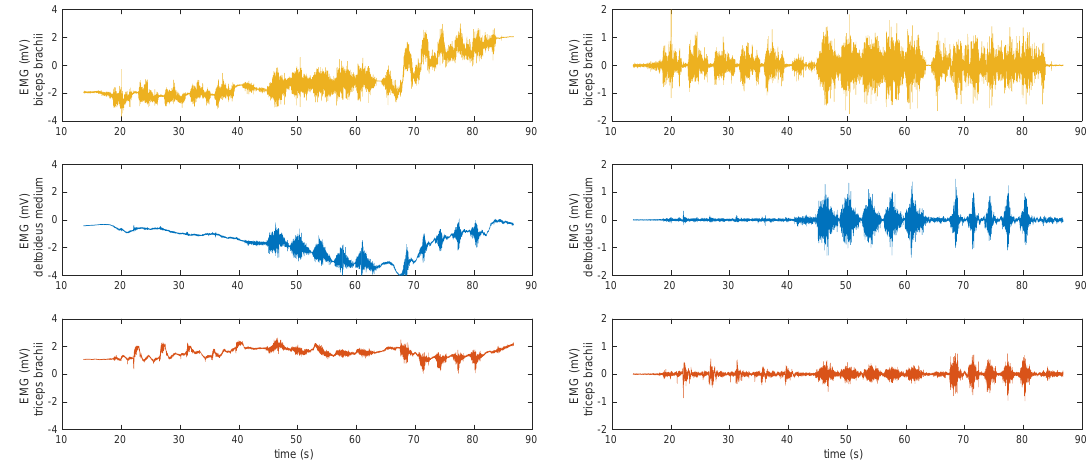
Figure 16. (Left panel) raw EMG signals acquired from the upper arm muscles, during three different exercises (5 reps each): biceps curls, lateral raises, vertical raises. (Right panel) the same signals after digital high-pass filtering to remove baseline